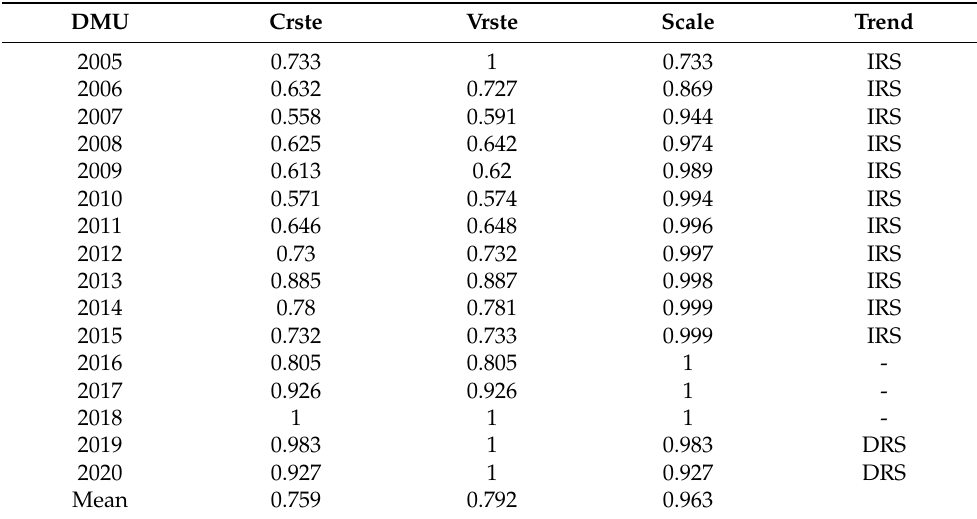
Table 5. Measurement results of China’s wind power development